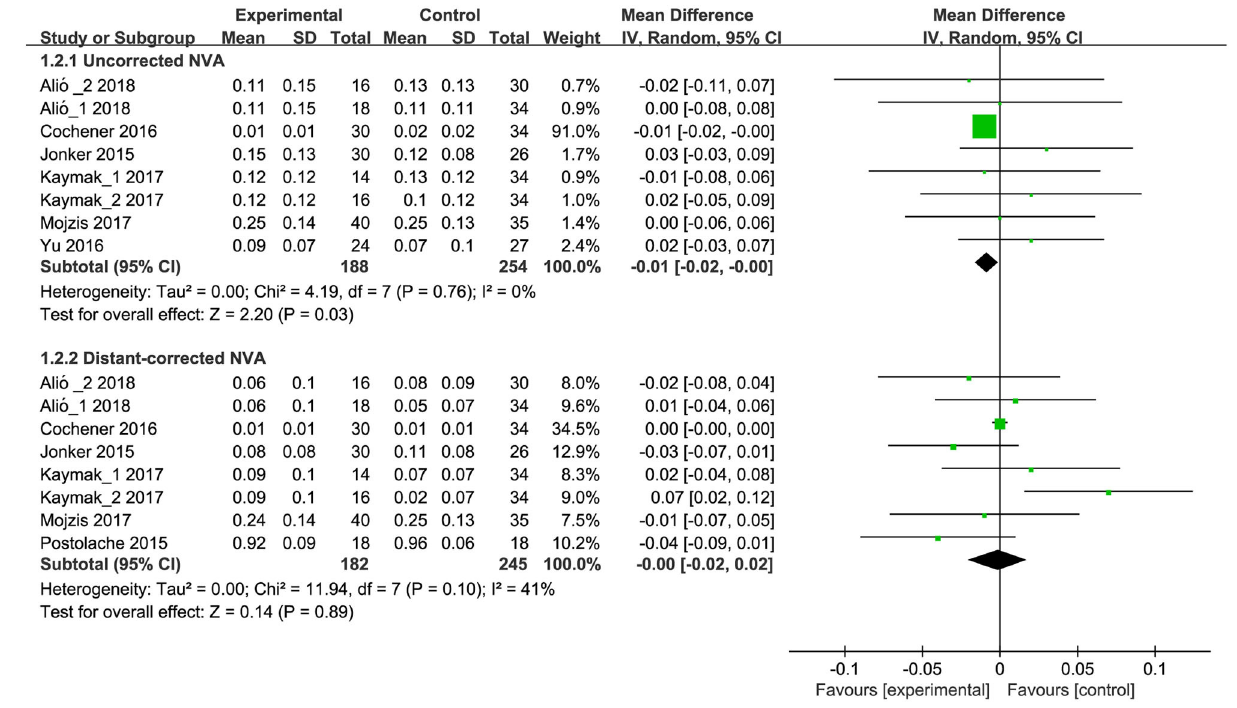
bifocal IOL with AT LISA 809M for uncorrected (MD, − 0.12; 95% CI, − 0.19 to − 0.04; P < 0.01; Supplementary Figure S3 ) and distant-corrected IVA (MD, − 0.10; 95% CI, − 0.18 to −